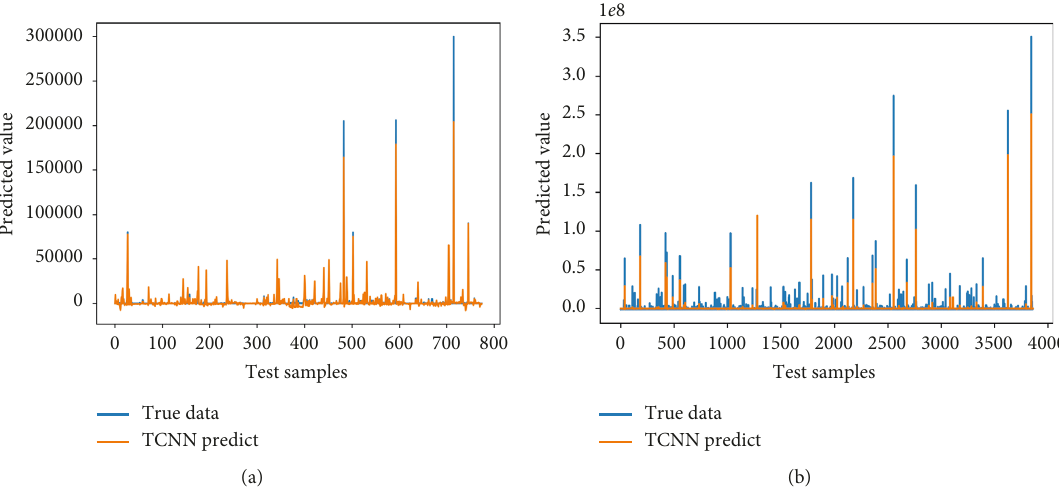
Figure 11: Testing performance of TCNN on (a) UCI seismic bumps and (b) AAIA ′ 16